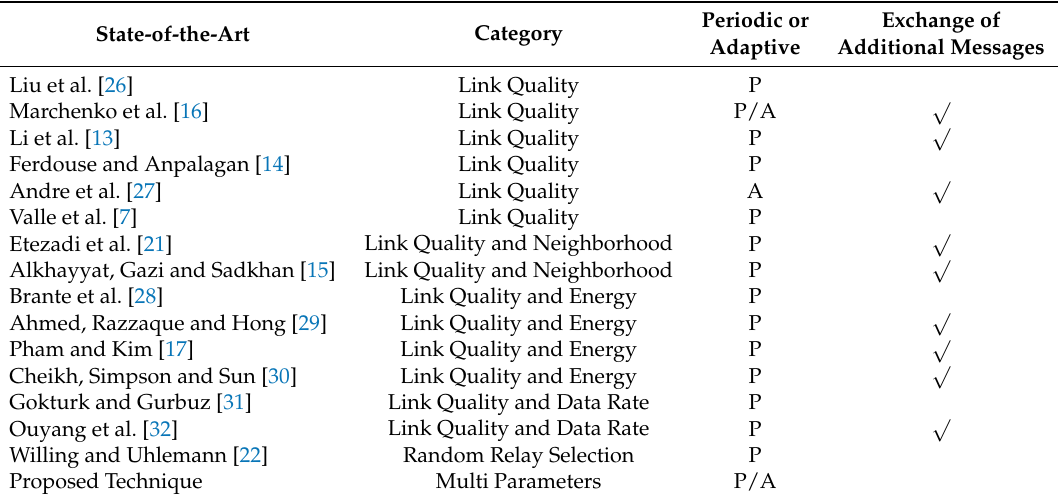
Table 1. Relay selection